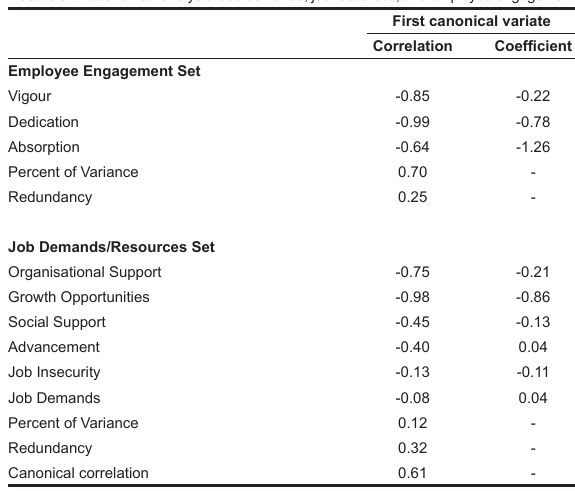
TABLE 7 Results of the canonical analysis: Job demands, job resources, and employee engagement